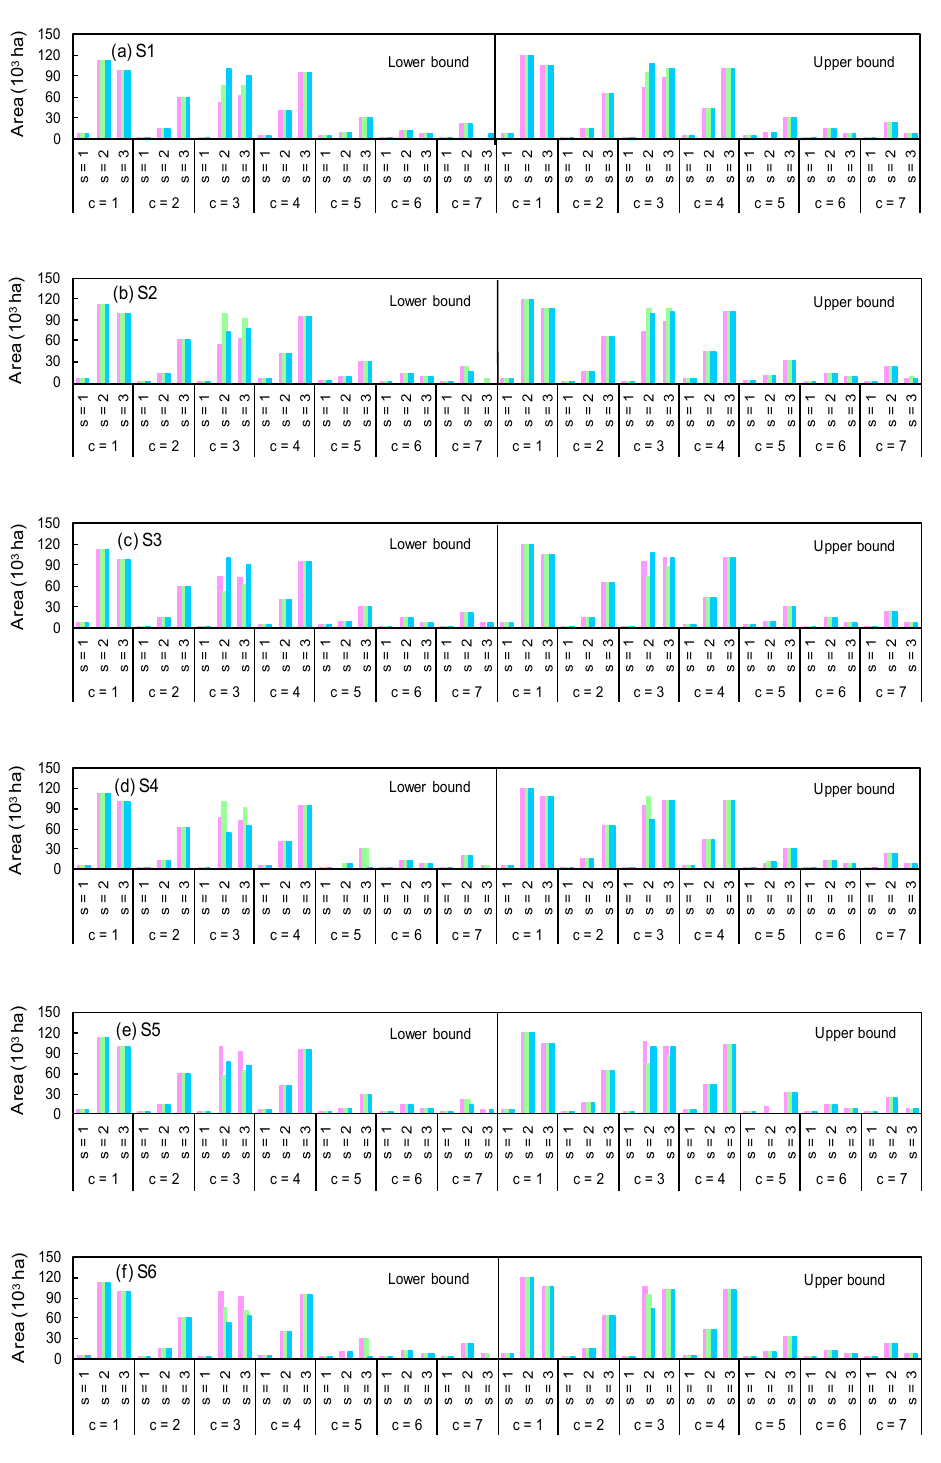
Figure 6. Cropland irrigated by groundwater: ( a ) S1, ( b ) S2, ( c ) S3, ( d ) S4, ( e ) S5, ( f )